Question: From the figure, is the trend upward or downward?
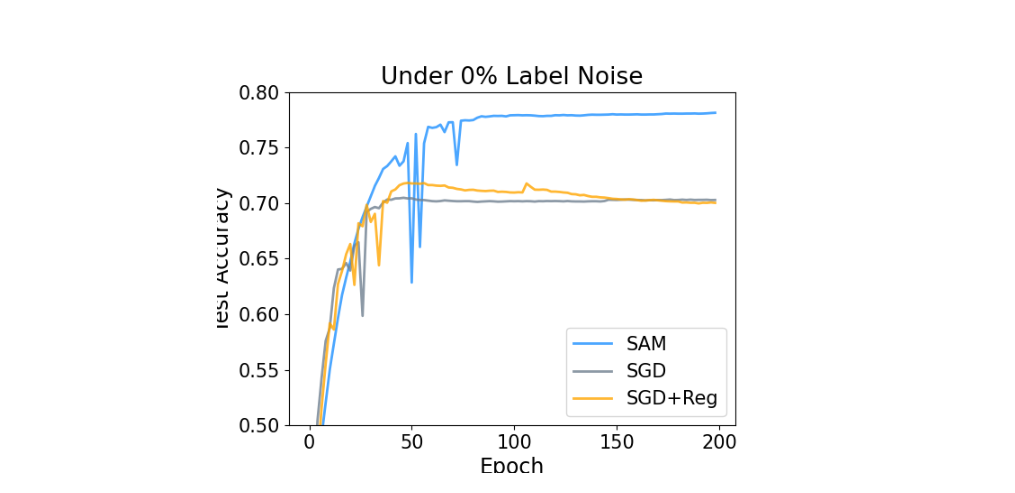
Answer: increasing